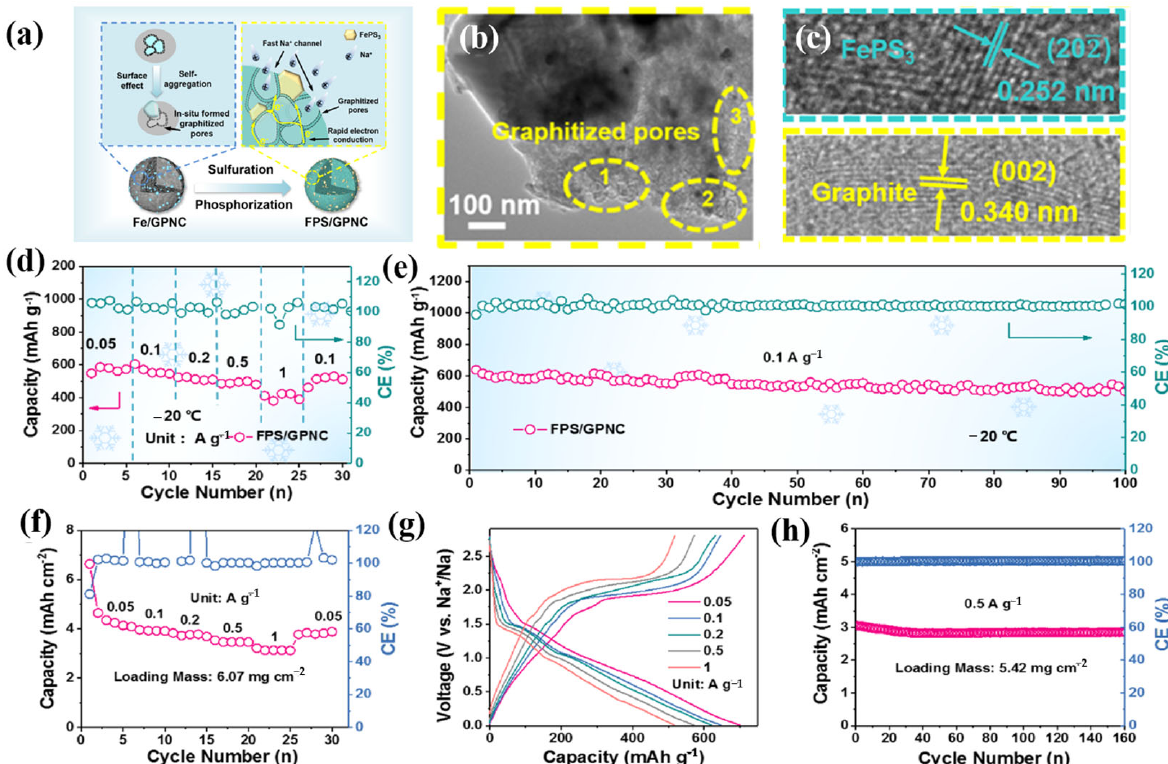
Figure 6. ( a ): Synthesis diagram of the FPS/GPNC composite. ( b , c ): HRTEM images of different magnifications, including the local amplification region of graphitized pores and lattices fringes. ( d ): Rate performance of the FPS/GPNC electrode at − 20°C. ( e ): Long ‐ cycling stability of the FPS/GPNC electrode at − 20°C. ( f ): Rate performance of the FPS/GPNC electrode with the loading mass of 6.07 mg cm − 2 . ( g ): Typical voltage profiles at different rates with the loading mass of 6.07 mg cm − 2 . ( h ): Long ‐ cycling performance of the FPS/GPNC electrode with the loading mass of 5.42 mg cm − 2 . ( a – h ) Reproduced with permission from [99].